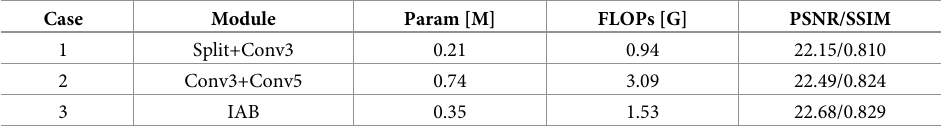
Table 5. Study on Information Aggregation Block (IAB). ACB, Aggregation are asymmetric convolutional block, aggregation structure